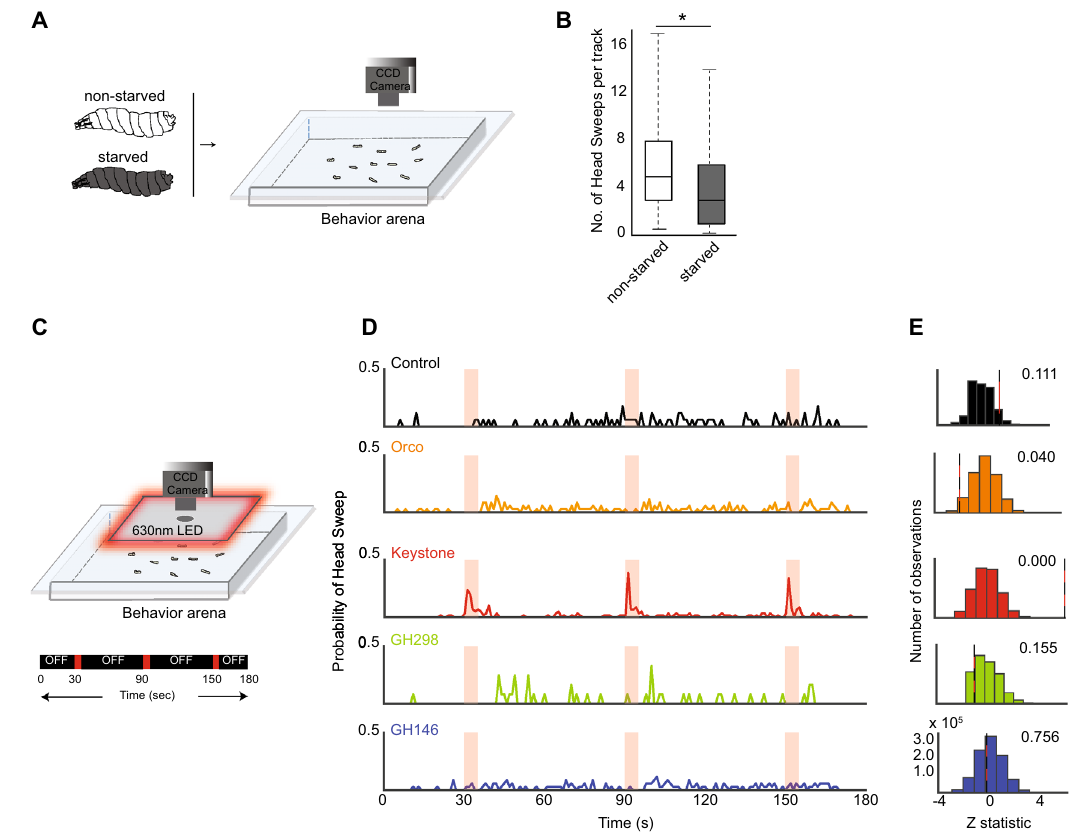
Figure 1. Keystone-LN activity triggers head-sweep behavior in the Drosophila larva. ( A ) Tracking assay. Starved and non-starved individuals of wild-type third-instar Drosophila larvae are imaged in the tracking assay. ( B ) The average number of head sweeps for each larval track is plotted on the -axis. Mann–Whitney U , *p < 0.05, n = 37 for non-starved condition, n = 47 for starved condition. ( C ) Optogenetics assay. Larval neurons expressing CsChrimson are activated by shining red-light on the behavior arena. Larval movements are recorded. The experimental paradigm is shown below the arena. Red-light stimulus is turned ON for 5 s at 30 s, 90 s, and 150 s. ( D ) The probability of head sweeps is plotted on y-axes for control larvae expressing no CsChrimson in any neurons (black) and for larvae expressing CsChrimson in Keystone-LN (red), GH146 subset of LNs (blue), GH298 subset of LNs (green), and all Orco-positive OSNs (orange). ( E ) Histograms of the calculated Z-statistics between a random 15 s and the remaining 165 s, repeated 1,000,000 times. Red and black lines represent the true Z-statistic between light ON and light OFF. Next to each red and black line is the fraction of replicates with a value greater than the true